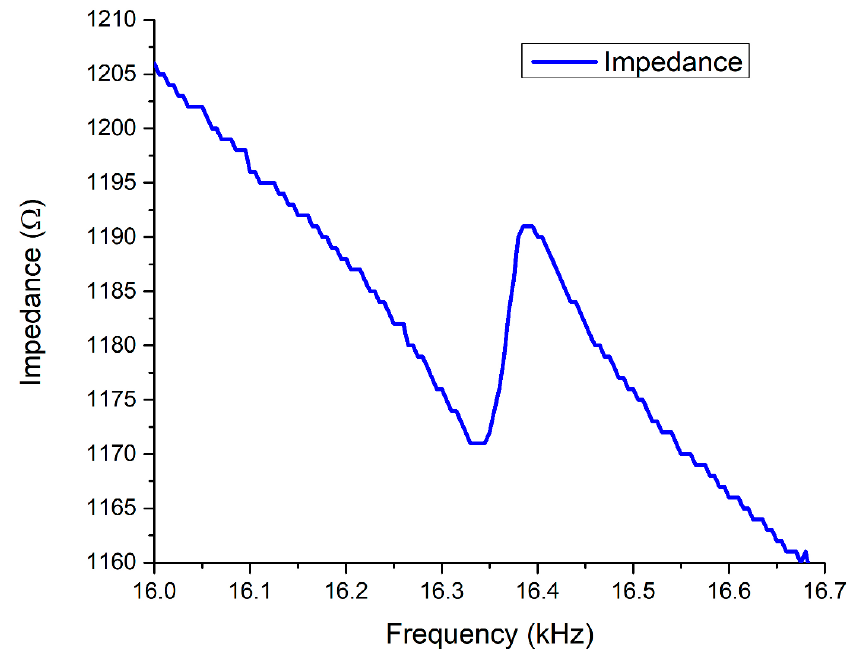
Figure 11. Impedance-frequency characteristics of the motor.